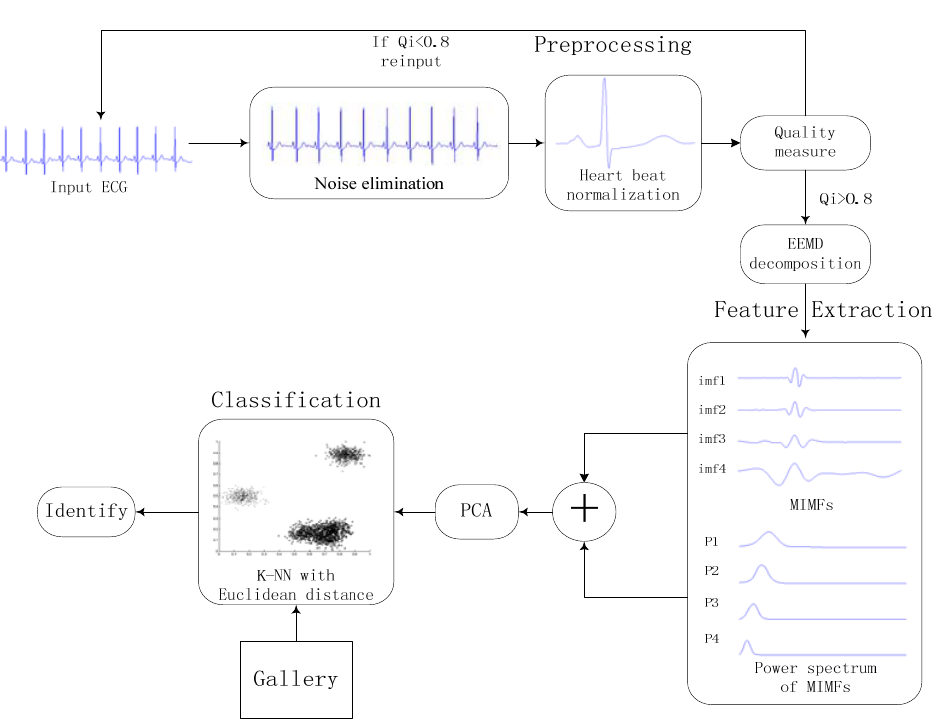
Figure 6. Block diagram of the proposed human identification